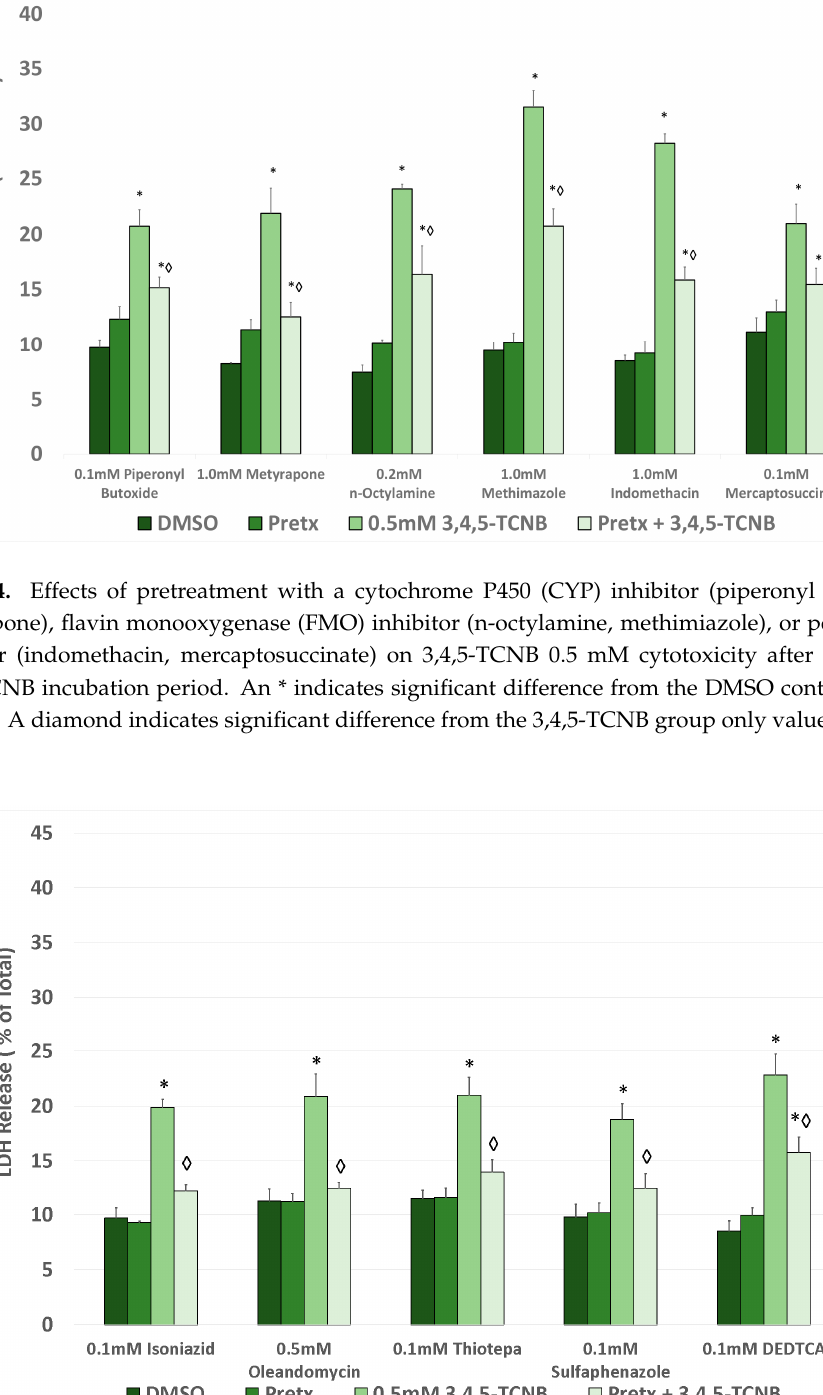
Figure 5. Effects of pretreatment with a CYP specific inhibitor on 3,4,5-TCNB 0.5 mM cytotoxicity after a 30 min 3,4,5-TCNB incubation period. An * indicates significant difference from the DMSO control value, p < 0.05. A diamond indicates significant difference from the 3,4,5-TCNB group only value, p < 0.05. n = 4.